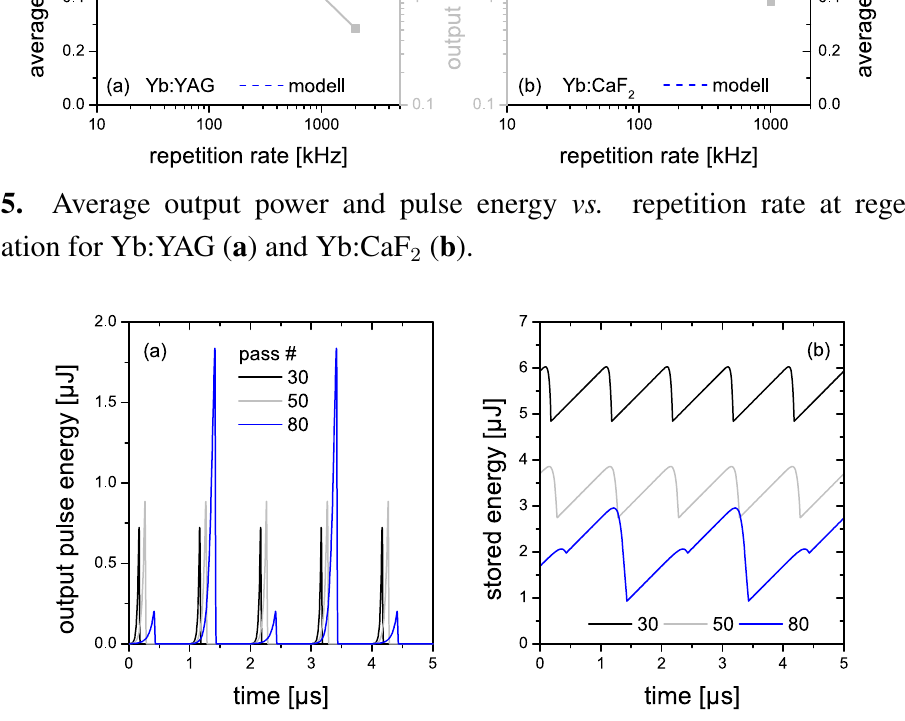
for a repetition rate of 1 2